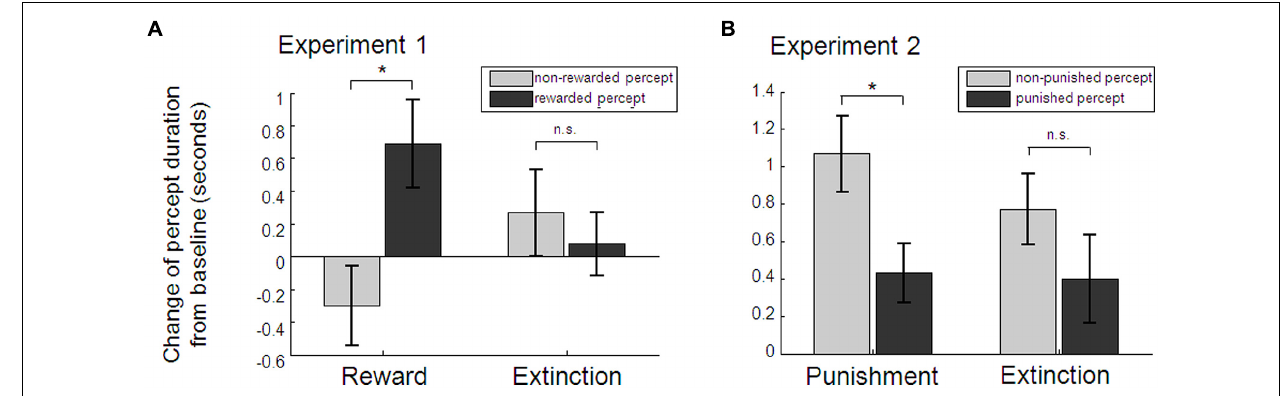
compared to baseline (B) . Reward and punishment effects were not persistent as indicated by no significant differences (n.s.) between percept durations during the extinction blocks. Note: sample sizes were n = 37 and n = 34 for Experiment 1 and 2, respectively; * p < 0.05, paired t -test. Error bars denote within-subject